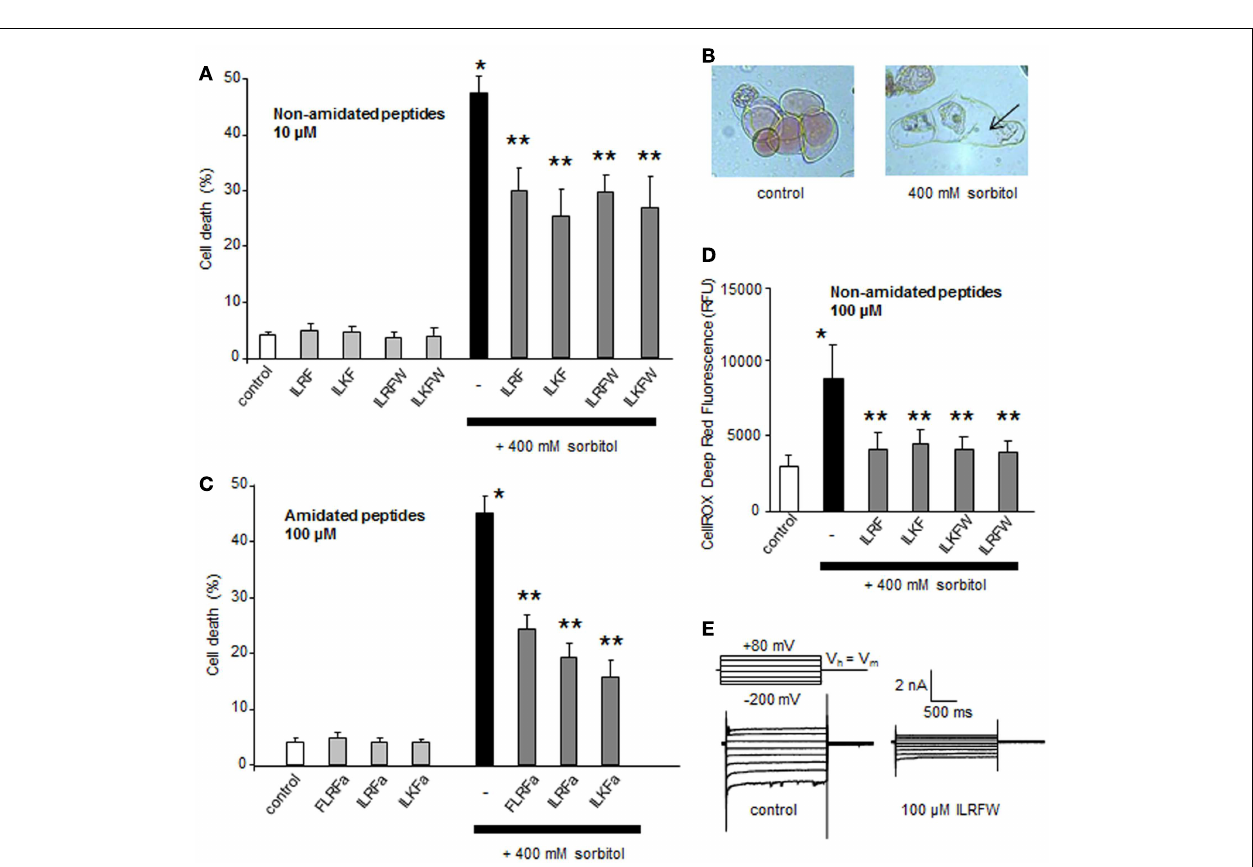
FIGURE 3 | Effect of different putative plant FLPs on sorbitol-induced cell death in Arabidopsis thaliana cells . (A) Effect of non-amidated synthetic FLPs (ILRF, ILKF, ILRFW, and ILKFW, 10 µ M each) on sorbitol-induced cell death extent. (B) Light micrographs of A. thaliana cultured cells stained with Neutral Red 6h after incubation with 400mM sorbitol (right) compared to living control cells maintained in their medium (left). Arrows indicate the cell shrinkage. (C) Effect of various amidated synthetic FLPs (ILRFa, ILKFa,